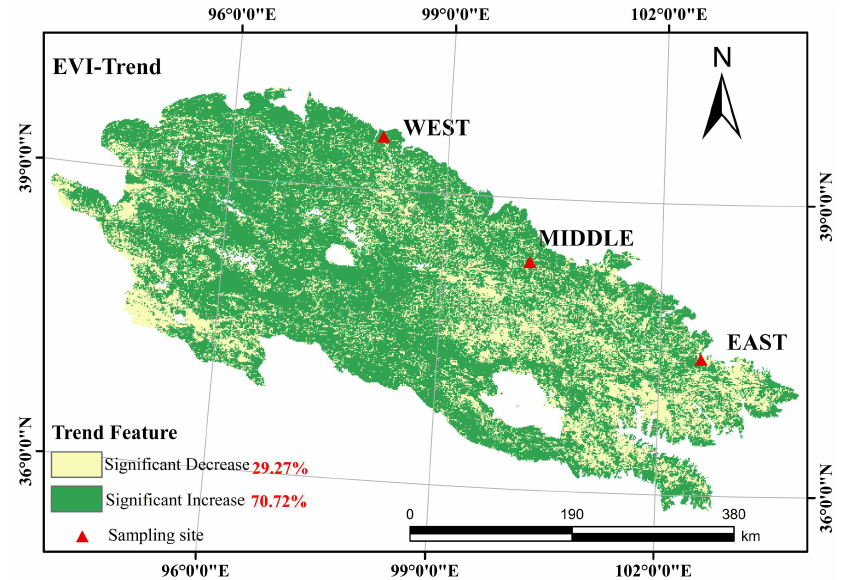
Figure 5. Spatial distribution of EVI trend in the Qilian Mountains from 2000 to 2020.